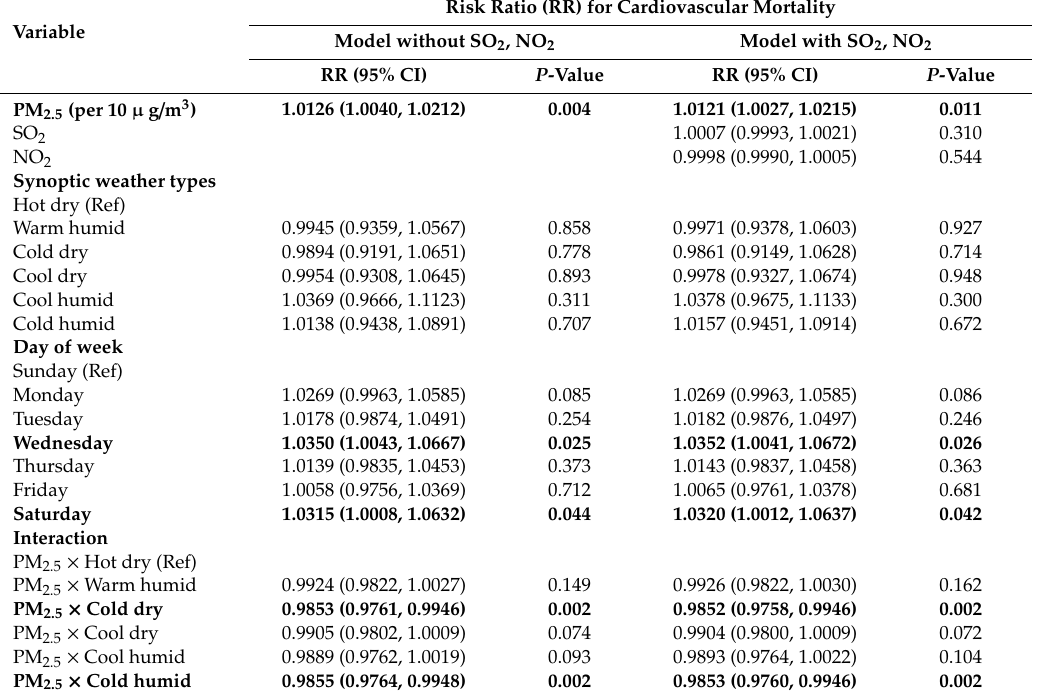
Table 1. Associations of PM 2.5 , synoptic weather types (SWTs), and their interactions with daily cardiovascular